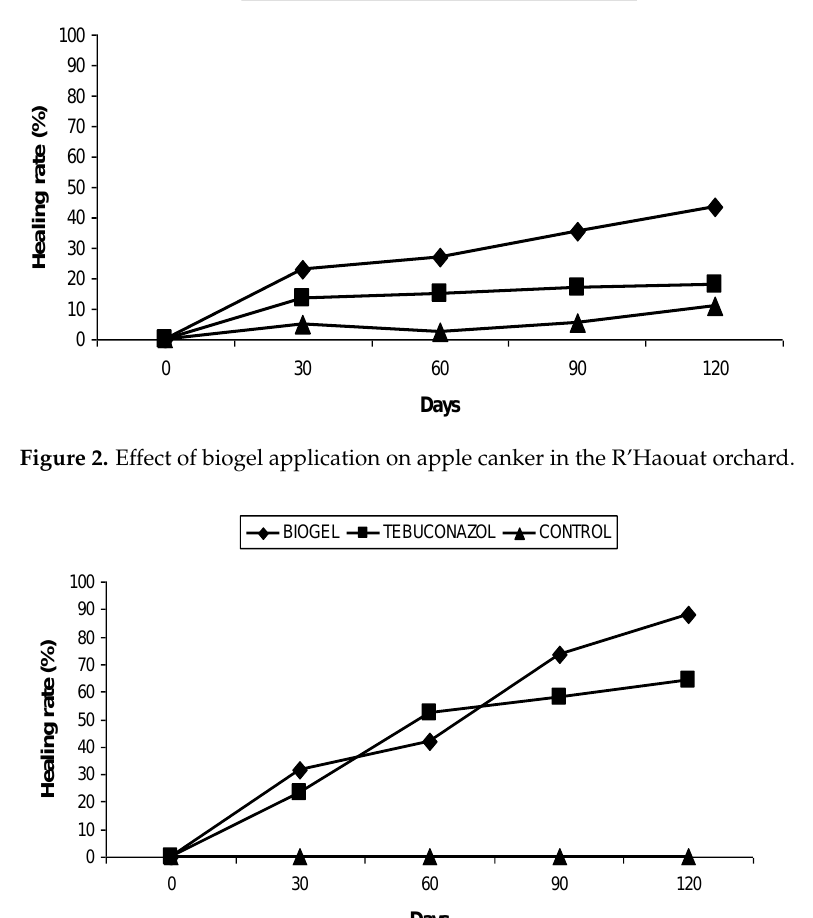
Figure 3. Effect of biogel application on apple canker in Bouhmama orchard.